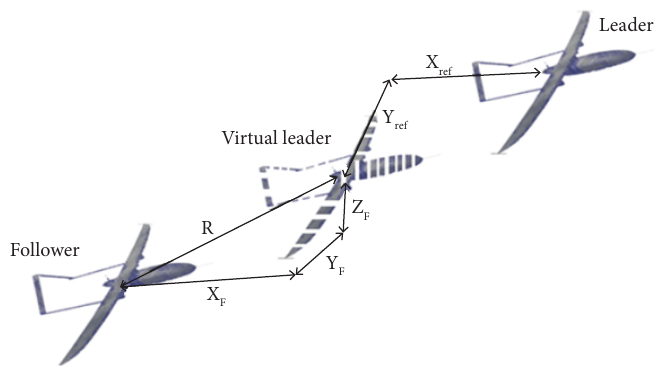
Figure 5. Distance parameter and virtual point position.